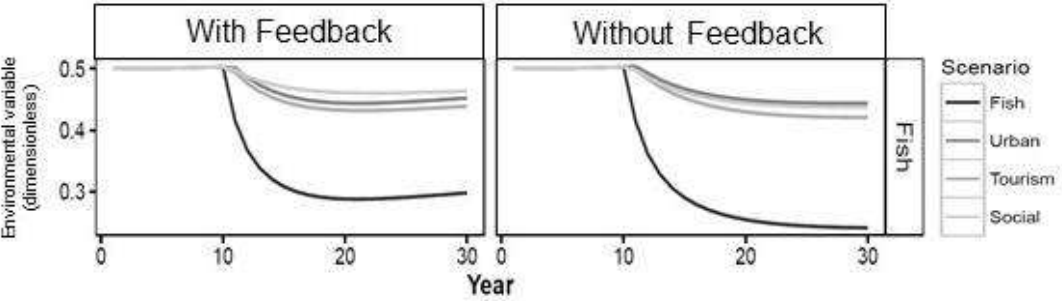
Figure A1.4: Predicted changes in relative fish abundance (F) for a hypothetical marine socio- ecological system with and without feedback between SoPI and the environmental variables land quality (L), marine quality (W), and fish abundance (F), for four perturbation